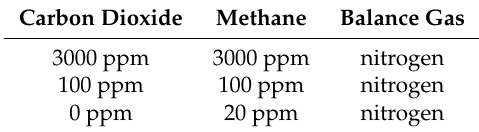
Figure 1. Component diagram of controlled gas exposure apparatus with chamber for diffusion-type sensors. Table 1. Calibrated gas mixtures used to prepare various gas mixtures with a carrier